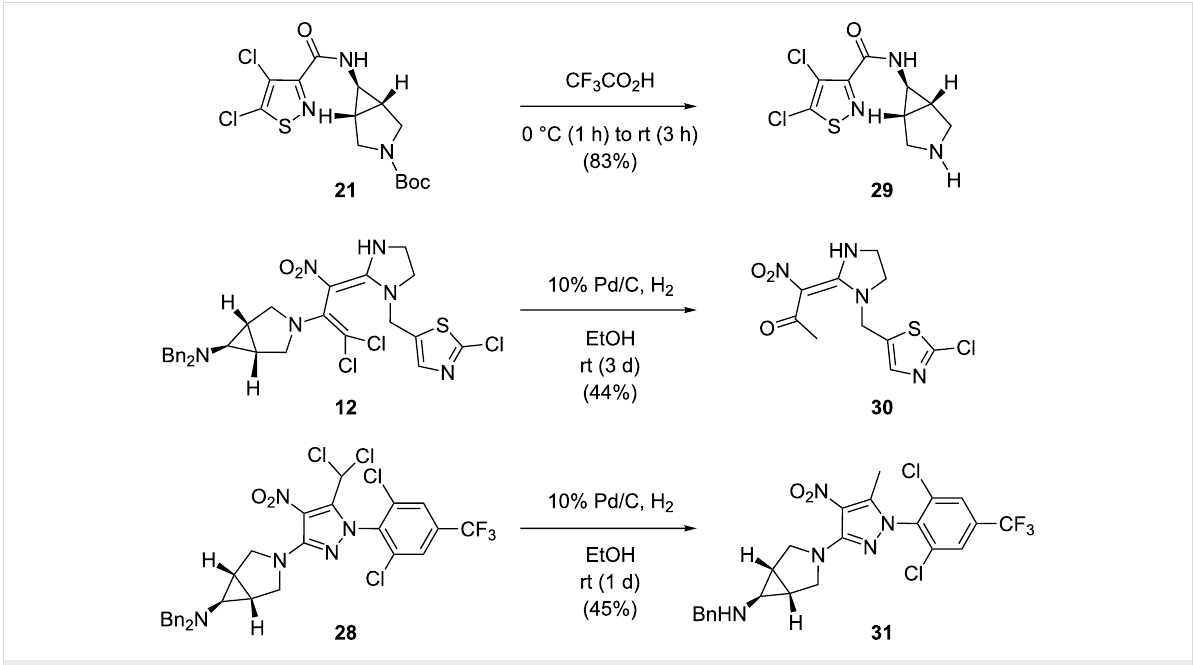
Scheme 8: Attempted deprotection of the azabicyclic compounds 21 , 12 , and 28